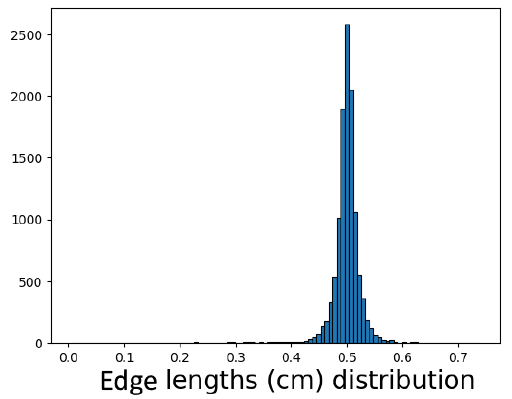
Figure 18. ( Top ) The uniform edge length graph model; ( Middle ) degree distribution of vertices; ( Bottom ) edge lengths’